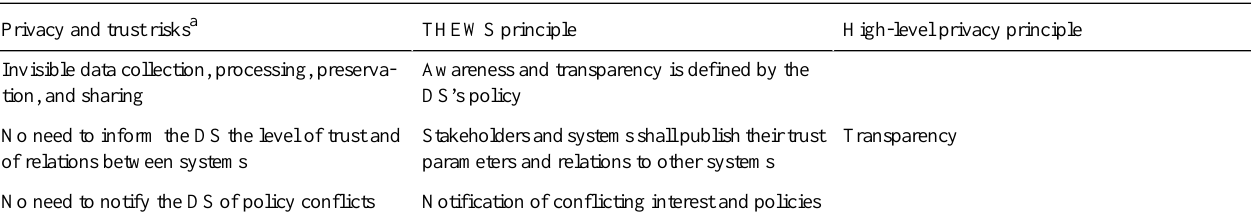
Table 4. Principles of